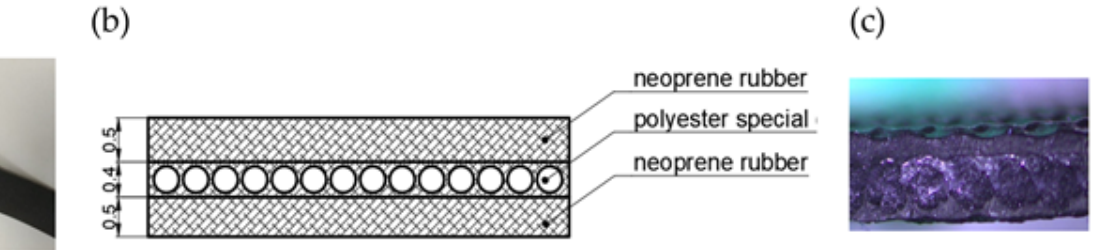
Figure 1. NE22 flat lane ( a ) photography, ( b ) belt cross section, ( c ) optical light microscopy images of the internal structure.